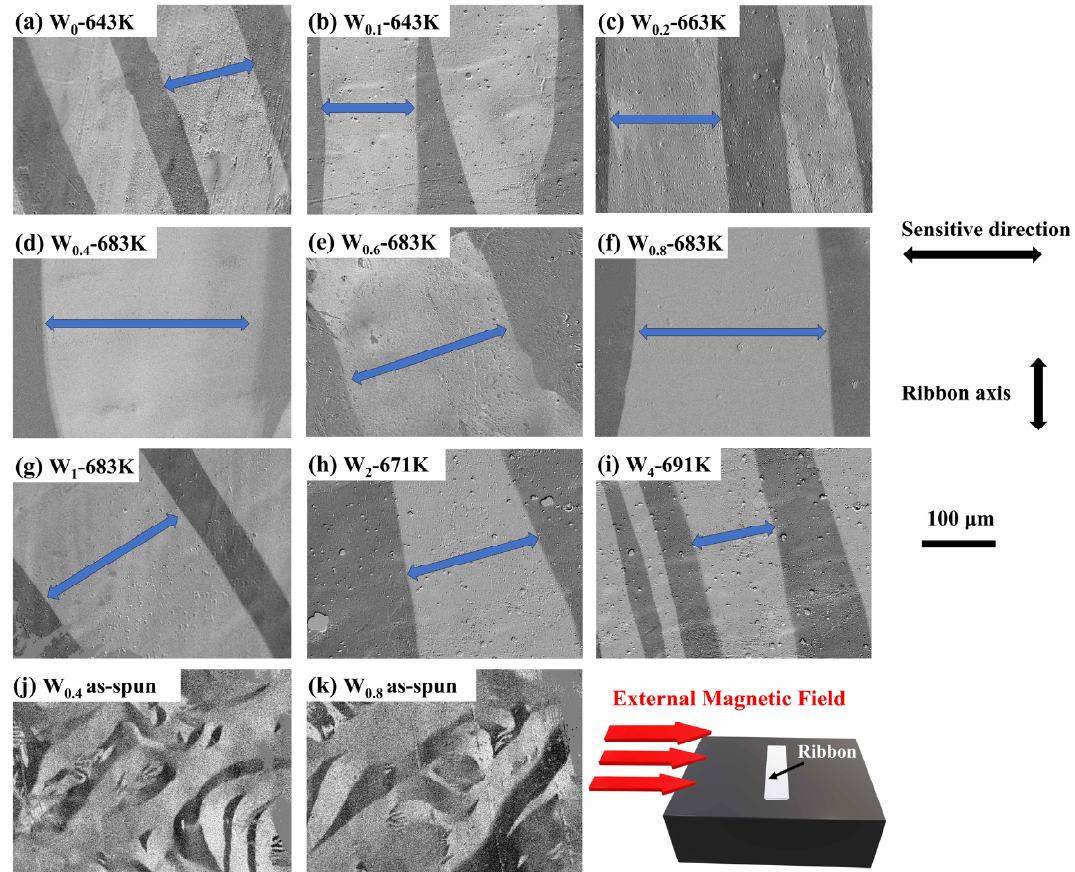
Figure 3. Magnetic domains of ( a , b ) W 0 and W 0.1 ribbon annealed at 643 K; ( c ) W 0.2 ribbon annealed at 663 K; ( d – g ) W 0.4 , W 0.6 , W 0.8 and W 1 ribbon annealed at 683 K; ( h ) W 2 ribbon annealed at 671 K; ( i )